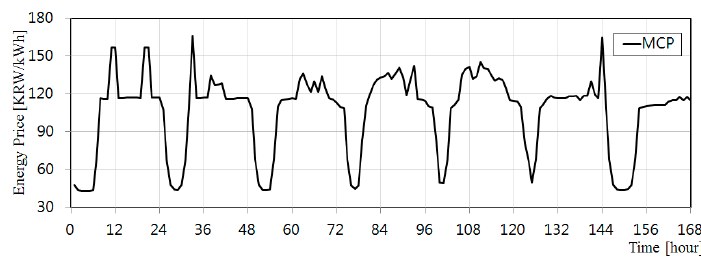
Energies 2017 , 10 , 207